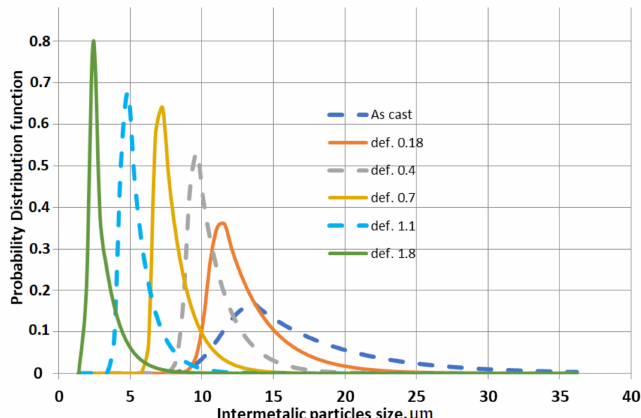
Figure 15. Evolution of size distribution of the intermetallic compounds during rolling from the as-cast state. The curves are plotted using the coefficients Nint, L and δ int0 for the 1565